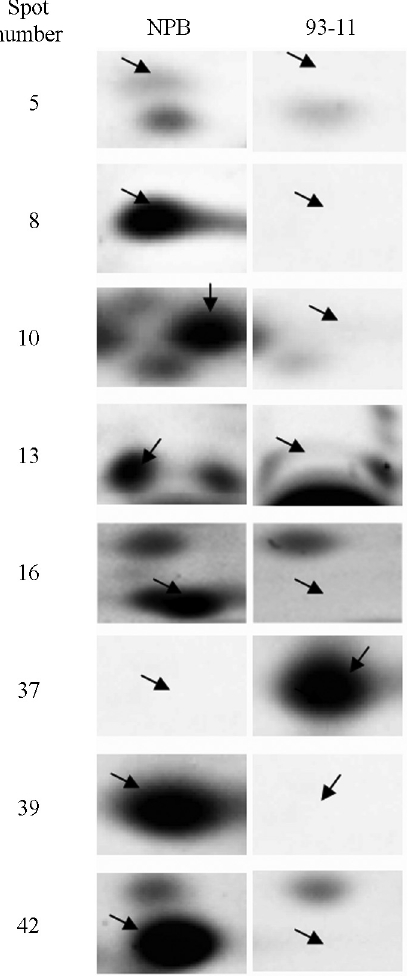
Figure 2 - The unique protein spots in Nipponbare and 93-11. NPB – Nipponbare.